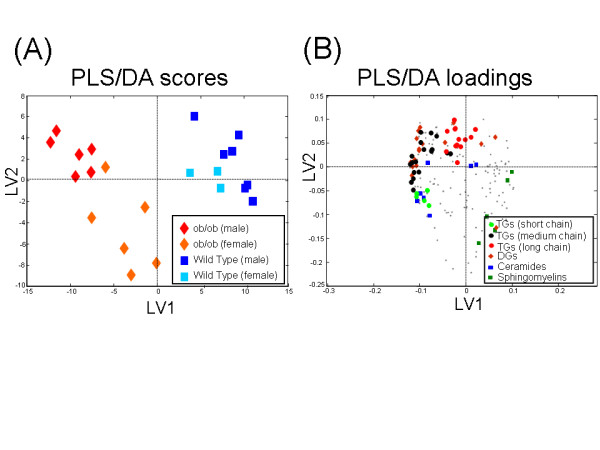
PLS/DA analysis of the ob/ob mouse model. (A) Score plot reveals genotype differences, as well as gender specific differences. (B) Loadings reveal major lipid classes associated with genotype differences.